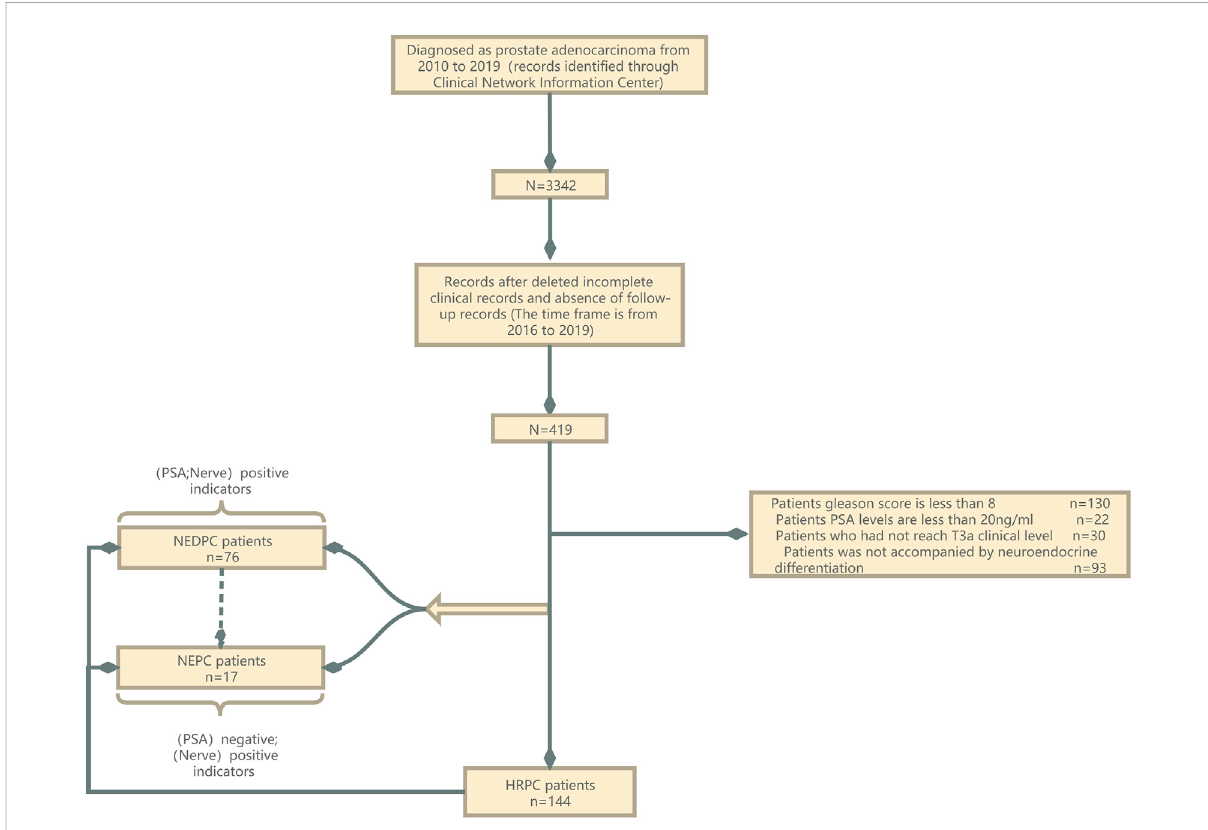
FIGURE 1 Patients fl ow diagram. NED, neuroendocrine differentiation; NEPC, neuroendocrine prostate cancer; HRPC, high-risk prostate cancer; PSA, prostate-speci fi c